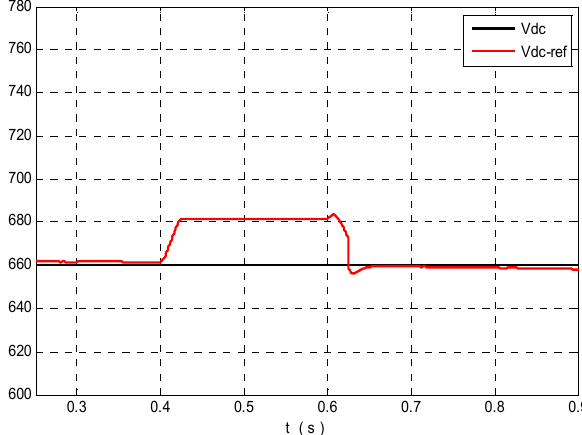
Figure 10. Simulation of the DC-bus voltage.